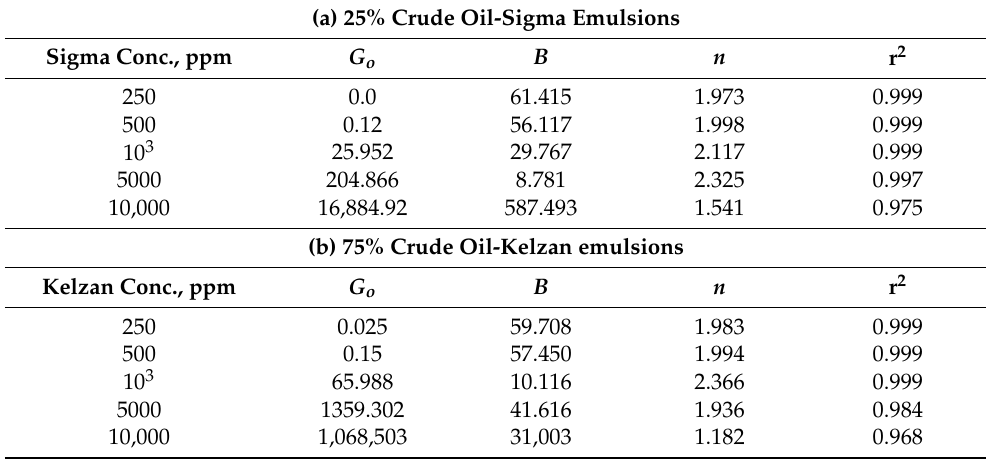
Table 2. Equation 4 fitting